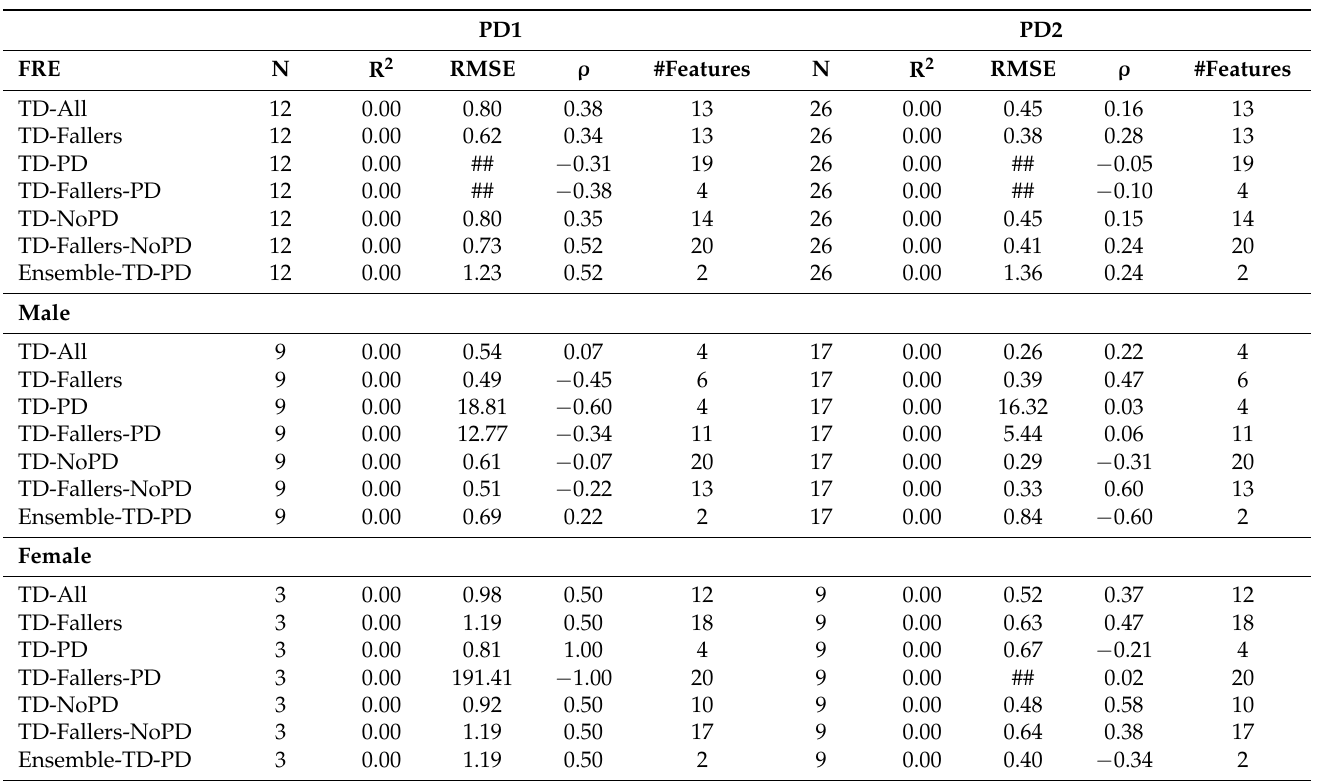
Table 3. Results for Poisson elastic net model tested on independent PD datasets (PD1 and PD2). Results are provided for each of the models derived from the TD training subsets. Spuriously high values are indicated by ##. Outliers ( NumFalls > 10) were excluded from analysis.